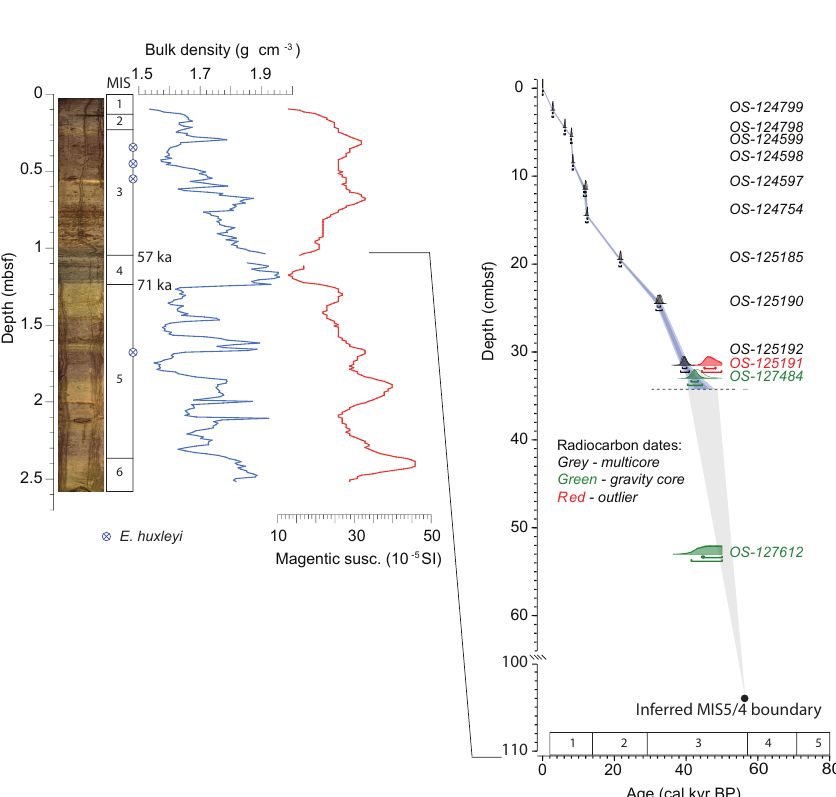
Figure 2. Chronology and stratigraphy of SWERUS-32-GC and 32-MC. Bulk density and magnetic susceptibility profiles for 32GC were previously correlated to the well-dated 96-12-1PC core by Jakobsson et al. (2016). Bulk density primarily reflects changes in grain size, with coarser material having a higher density than finer-grained material. The overall position of MIS 5 is supported by the occurrence of E. huxleyi . The chronology for the upper 30–35cm is based on radiocarbon dating in both 32-MC and 32-GC. Beyond the range of radiocarbon dating, an extrapolation to the inferred position of the MIS 3–4 boundary (57ka at 105cm) is